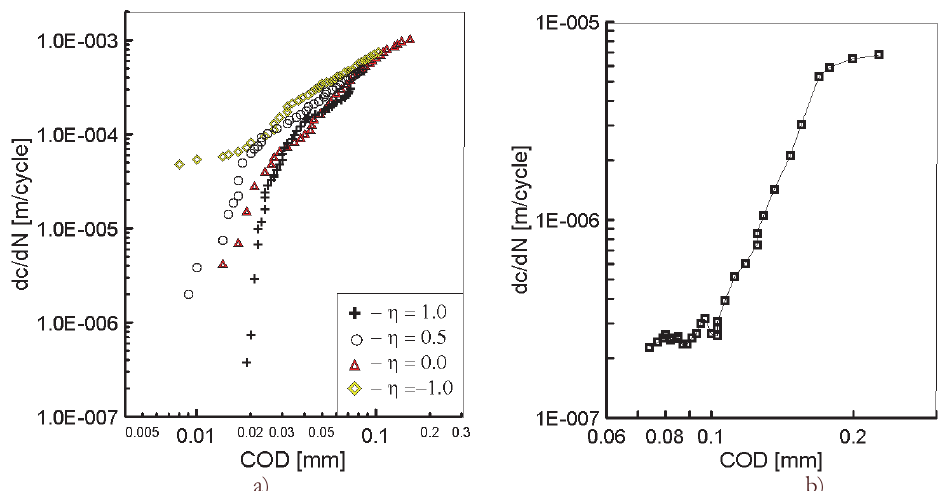
Figure 11: Crack growth rate on free surface of (a) cruciform specimens and (b) bending plate versus COD.